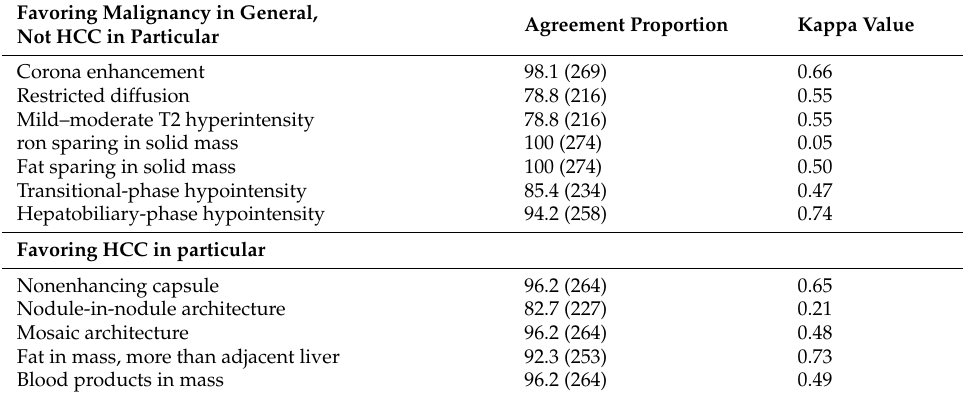
Table A2. Inter-observer agreement for AFs in the 274 nodules.